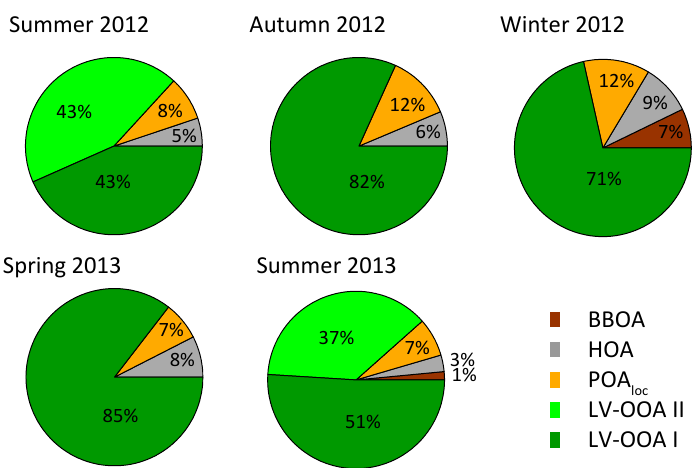
Figure 9. OA source contributions for all seasons. Orange: POA loc ; grey: HOA; brown: BBOA; dark green: LV-OOA I; light green: LV- OOA